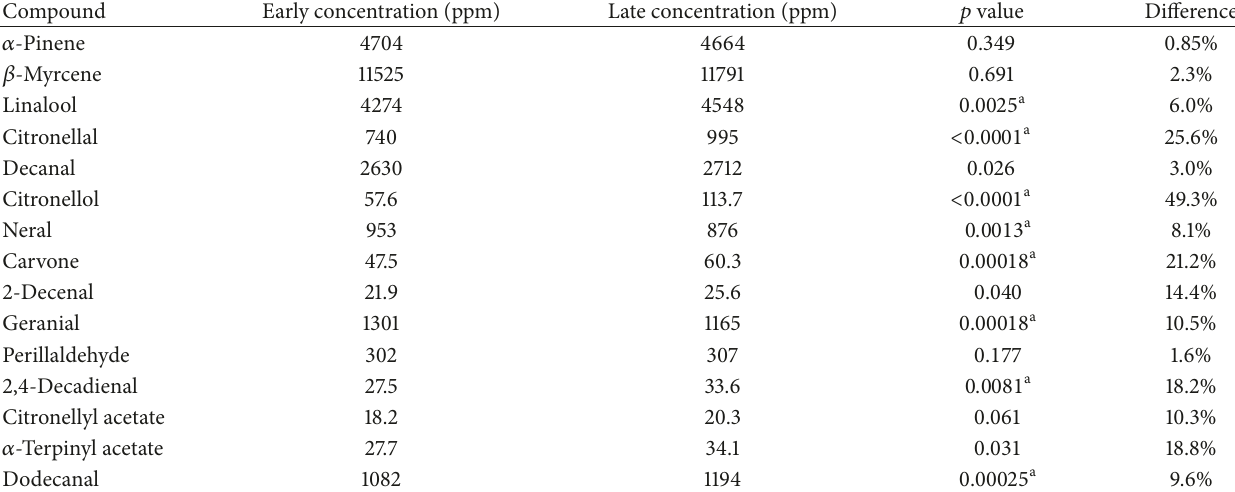
Table 10: Valencia symptomatic early versus late compound